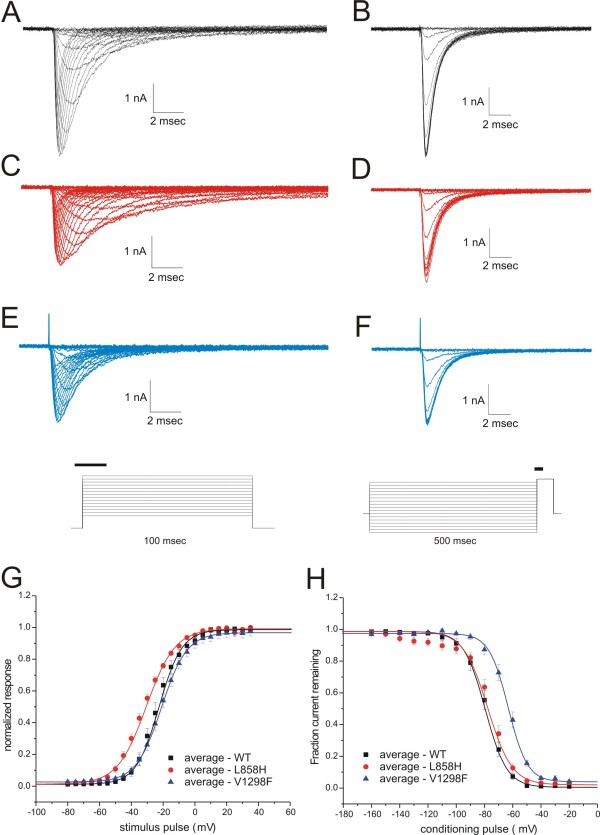
Voltage-dependence of WT and the L858H and V1298F mutant channels. (A) Superimposed activation traces recorded from a representative HEK + hNav1.7r-WT expressing cell. (Average peak current is -4.2 ± 0.7 nA, n = 12) (B) Superimposed fast-inactivation traces recorded from the same cell as in (A). (C) Superimposed activation traces recorded from a representative HEK + hNav1.7r-L858H expressing cell. (Average peak current is -2.3 ± 0.3 nA, n = 12). (D) Superimposed fast-inactivation traces recorded from the same cell as in (C). (E) Superimposed activation traces recorded from a representative HEK + hNav1.7r-V1298F expressing cell (Average peak current is -1.9 ± 0.3 nA, n = 18). (F) Superimposed fast-inactivation traces from the same cell as in (E). Insets illustrate the voltage pulse protocols for activation and fast-inactivation. The bold bars indicate the portion of the data sweeps displayed in this figure. (G) Normalized conductance-voltage (G-V) curves are constructed from the averages of individual HEK 293 cells expressing WT (black squares, n = 12), the IEM mutation L858H (red circles, n = 12), or the PEPD mutation V1298F (blue triangles, n = 18). (H) Normalized fast-inactivation curves are constructed from the averages of the same cells as in panel G.